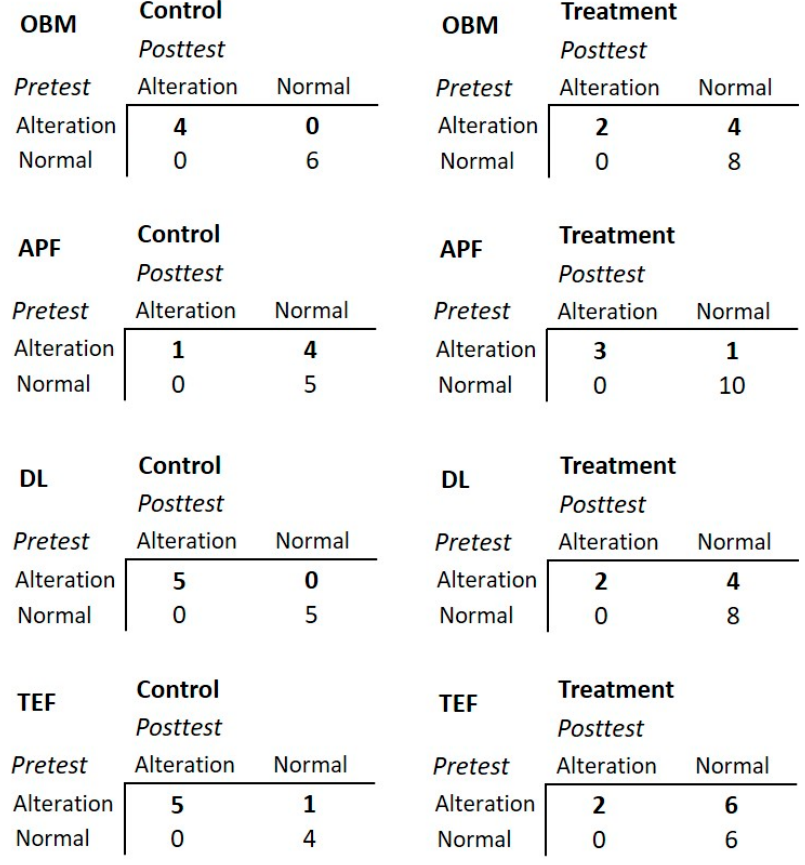
Figure 2. Overall improvement of congenital heart disease pediatric patients.